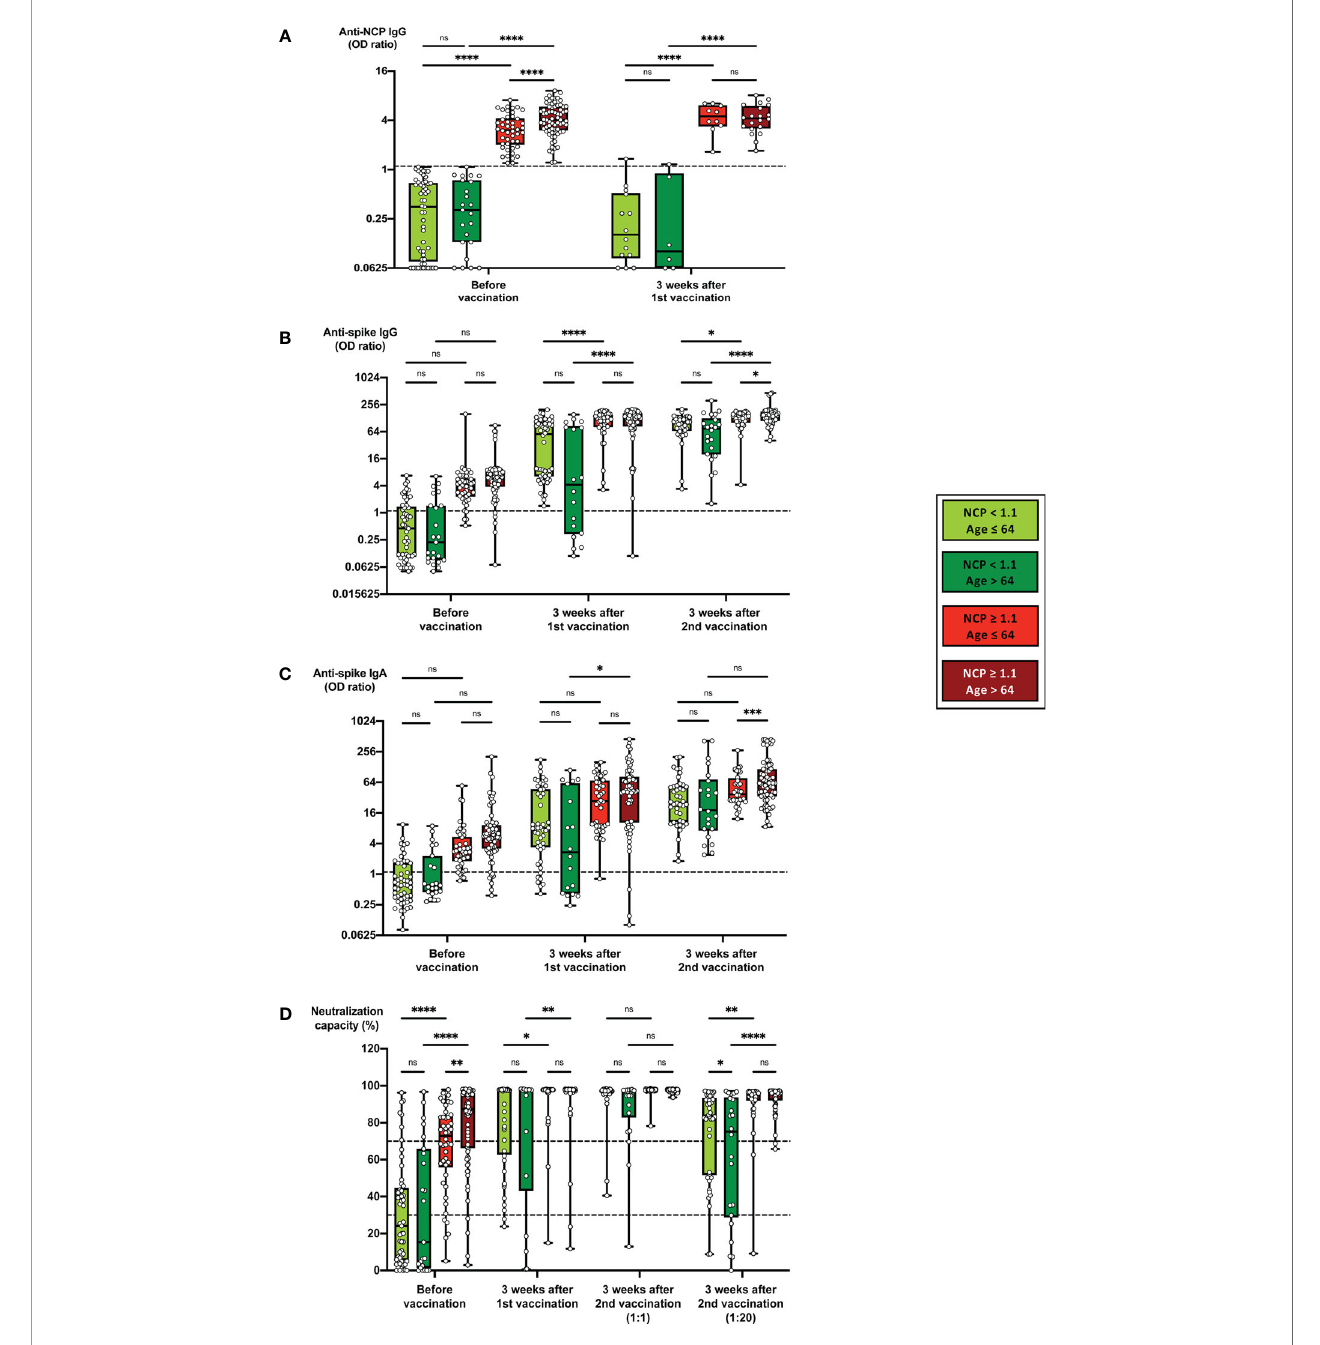
FIGURE 4 | Impact of age on the development of humoral immune parameters after vaccination. Serum samples from 51 subjects with anti-NCP IgG OD ratios < 1.1 and an age < 64, from 22 subjects with anti-NCP IgG OD ratios < 1.1 and an age ≥ 64, from 46 subjects with anti-NCP IgG OD ratios ≥ 1.1 and an age < 64 and from 71 subjects with anti-NCP IgG OD ratios ≥ 1.1 and an age ≥ 64 were collected before vaccination, 3 weeks after fi rst vaccination and 3 weeks after second vaccination with BNT162b2. Samples were analyzed for anti-spike IgG and IgA titers, anti-NCP IgG titers as well as for ACE2-RBD neutralization capacities. Box blots show (A) anti-NCP IgG titers, (B) anti-spike IgG titers, (C) anti-spike IgA titers and (D) median neutralization capacities at different time points as indicated. Dotted lines indicate cutoff values. To further differentiate high neutralization capacities 3 weeks after second vaccination, an additional analysis using an extra serum pre-dilution of 1:20 was performed (blot pair on the right side in panel D). Box central horizontal lines indicate medians, box borders represent IQR, whiskers indicate minima and maxima. Signi fi cance levels were *p < 0.05, **p < 0.005, ***p < 0.0005 and ****p < 0.00005. ACE2, angiotensin-converting enzyme 2; IQR, interquartile ranges; NCP, nucleocapsid; ns, not signi fi cant; OD, optical density; RBD, receptor-binding